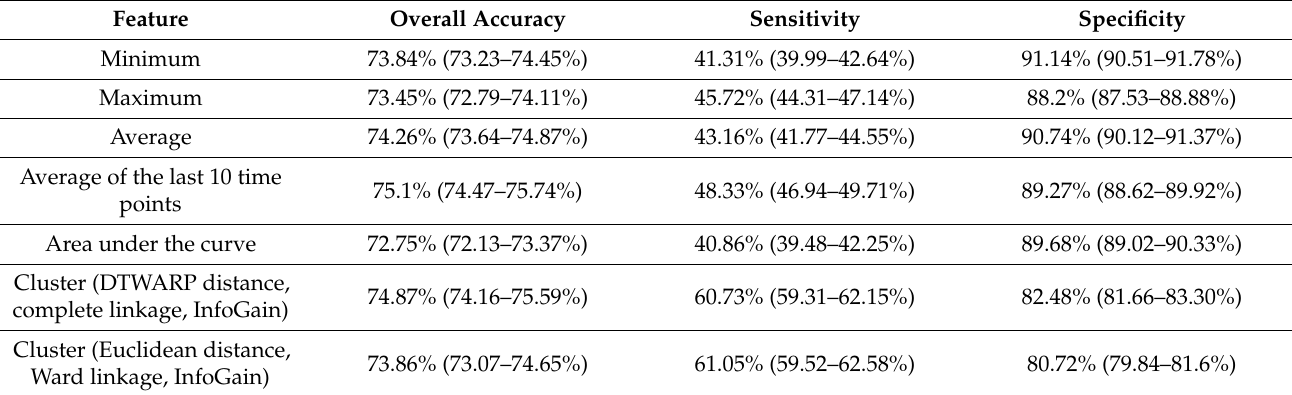
Table 3. Classification results using